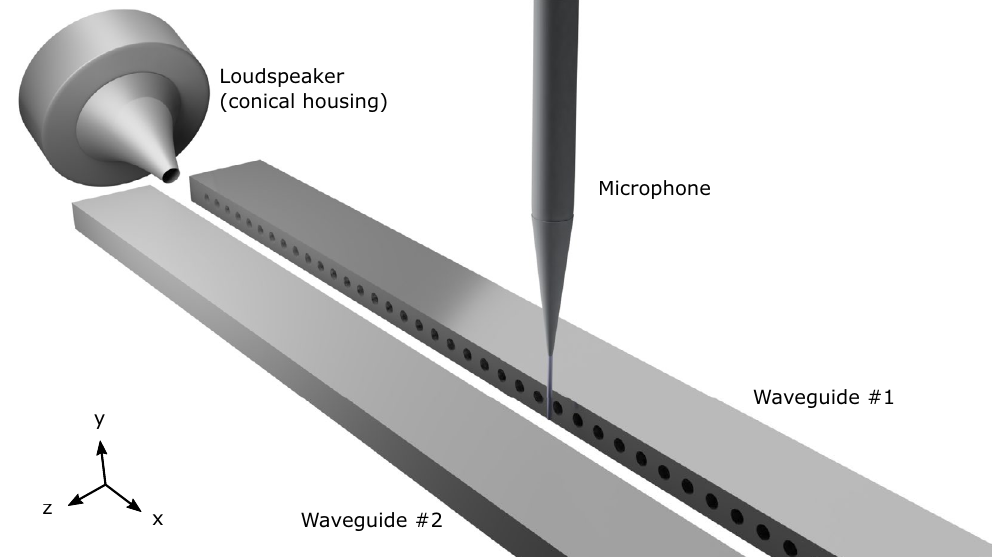
Figure 3. Render illustrating the acoustic measurement experiment, the loudspeaker mounted within the conical housing is shown positioned at a grazing incident angle to the sample and the microphone positioned within the formed cavity between the